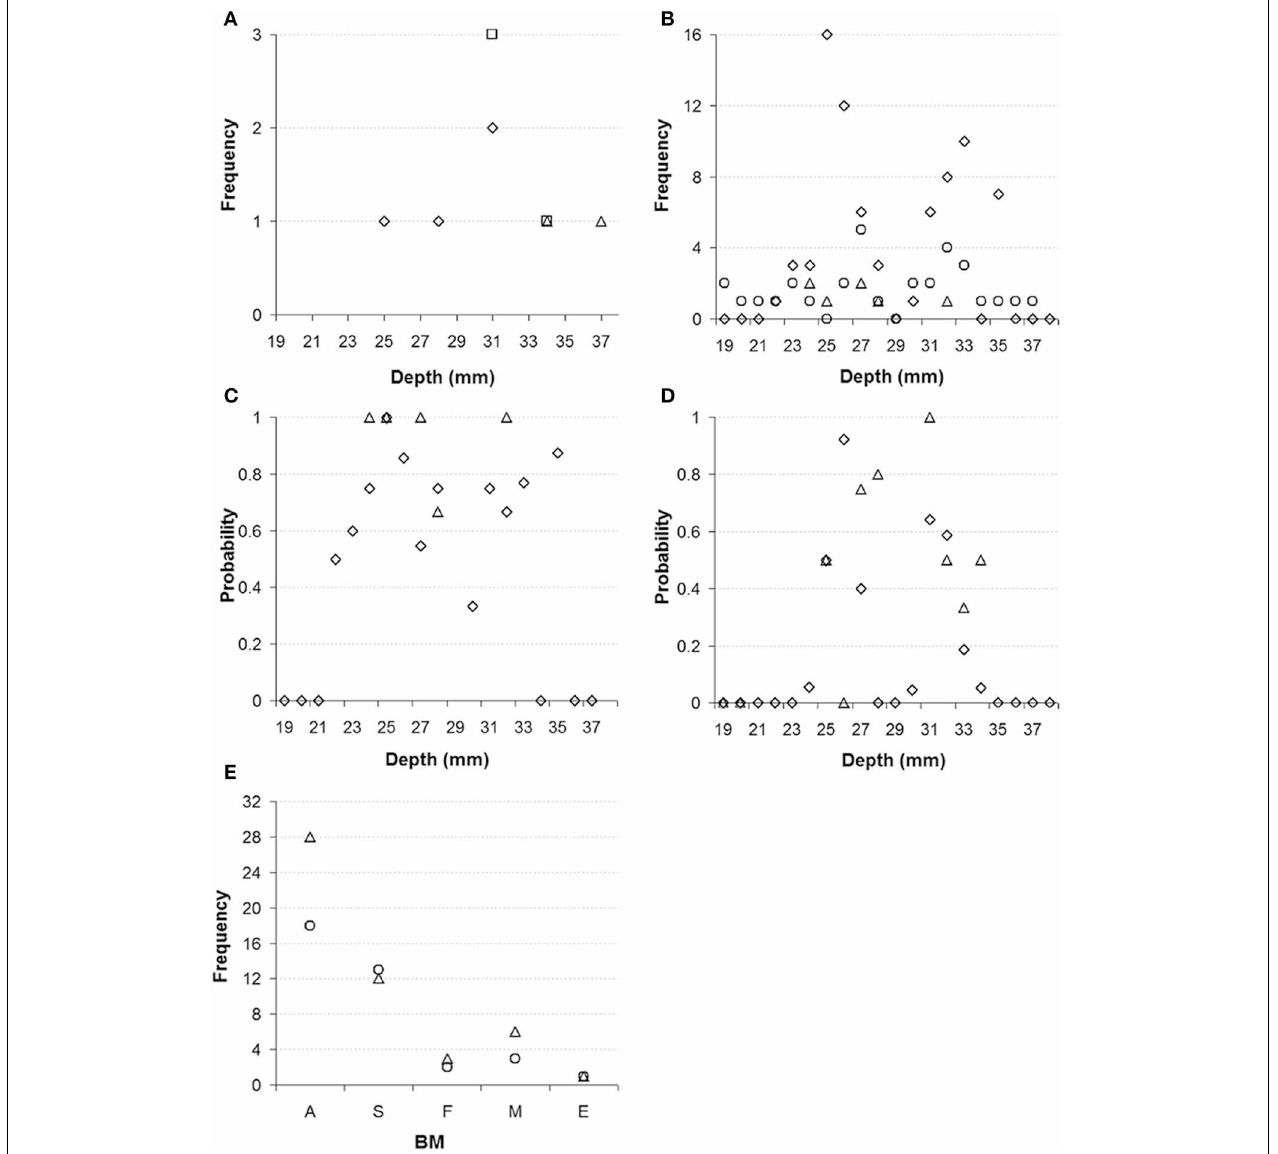
FIGURE 2 | (A) Representative electrode track through the left and right red nucleus in monkey E. Diamonds represent where electrical stimulation evoked upper body movements (indicative of red nucleus), squares represent responses to auditory stimulation, and triangles represent locations where no responses to electrical stimulation were observed. (B) Frequency of sites where electrical stimulation evoked upper body movement for all electrode tracks (diamonds monkey E, triangles monkey W) and frequency of